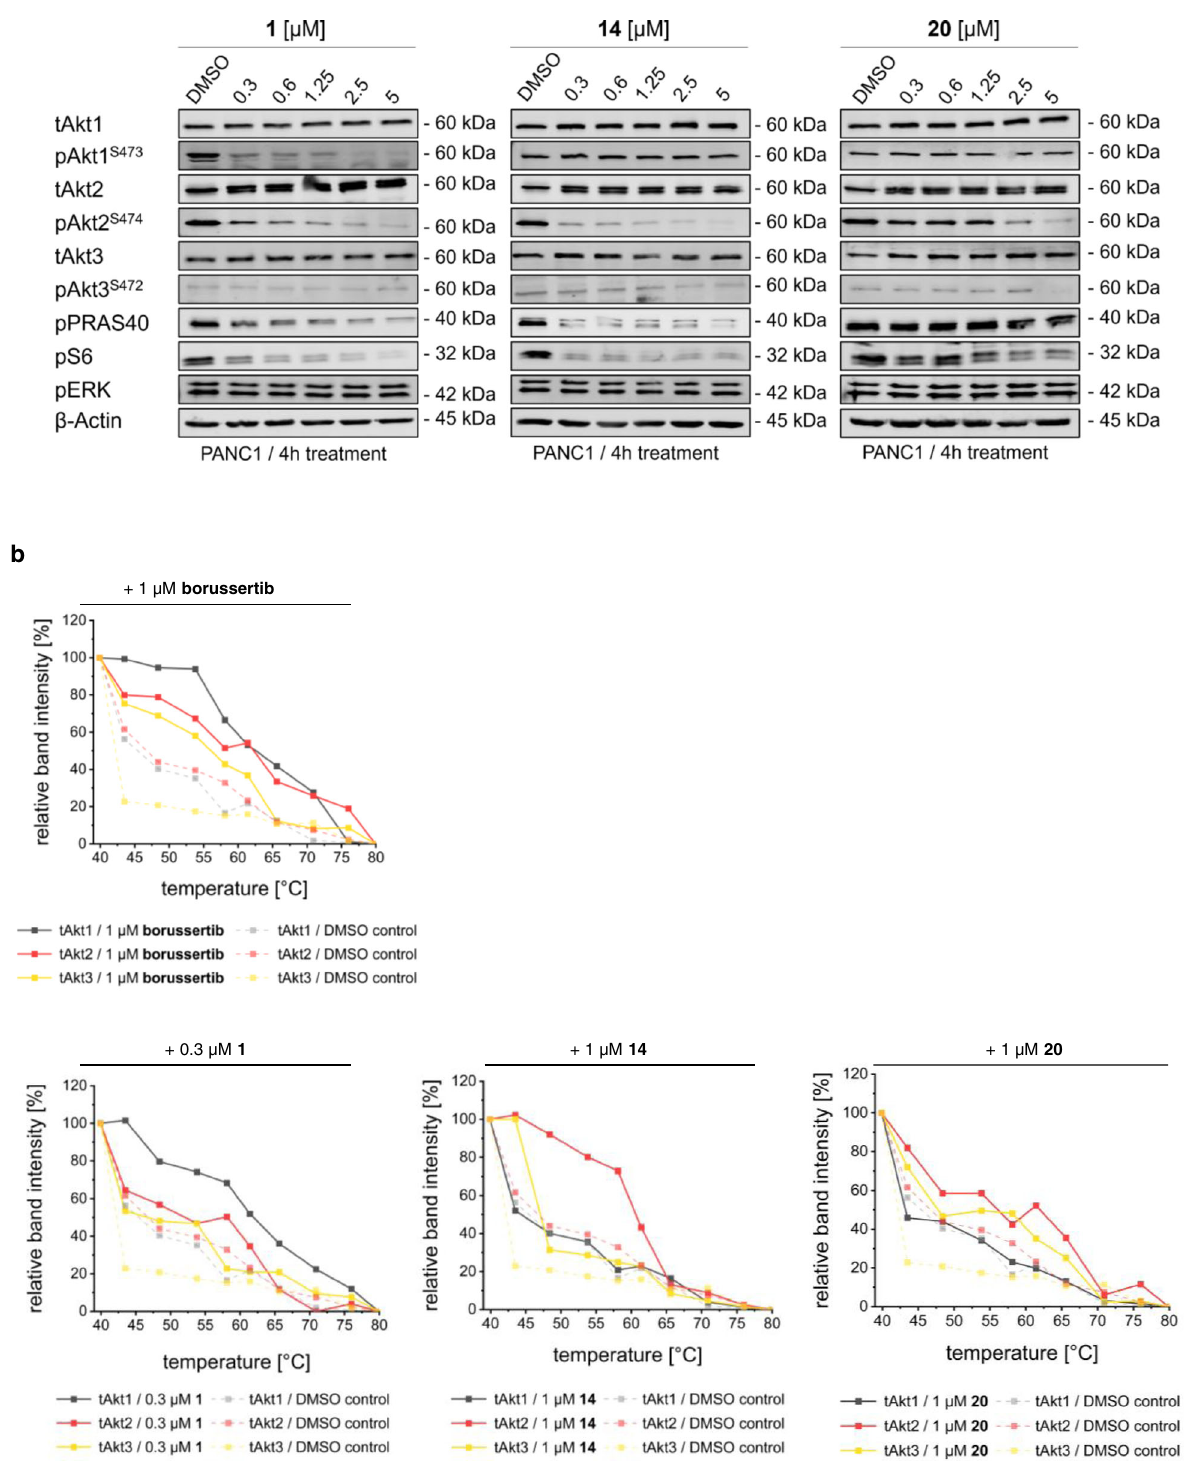
Fig. 5 Promising Akt isoform-selective inhibitors tested in PANC1 cell line. a Immunoblots to elucidate dose-dependent downregulation of individual Akt isoform activity after 24-h treatment, with pAkt1 and pAkt2 speci fi c antibodies ( n = 1 biologically independent experiment). b CETSA in PANC1 with inhibitors 1 , 14 , and 20 at different inhibitor concentrations and DMSO as control. The experiment was performed once. Source Data are provided with this